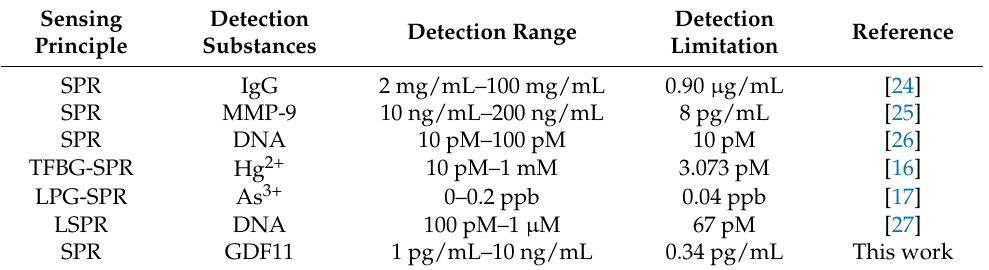
Table 2. Performance comparison of different optical fiber biochemical